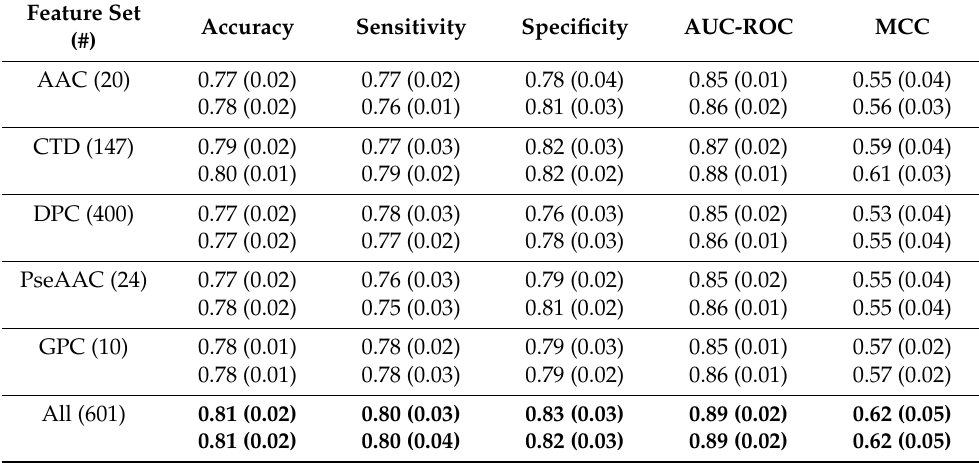
Table 1. Comparison of different feature sets for Gram+ (white) and Gram − (grey) AMP prediction. The values in brackets represent the standard deviation obtained via 10-fold cross validation. Bold values indicate the best value per